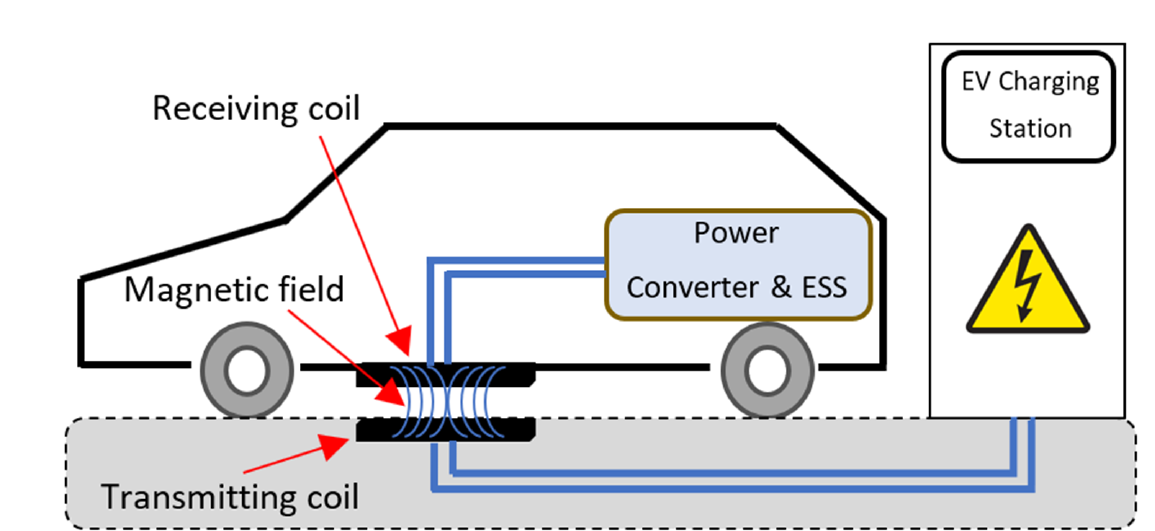
Figure 6. EV wireless charger overview diagram.